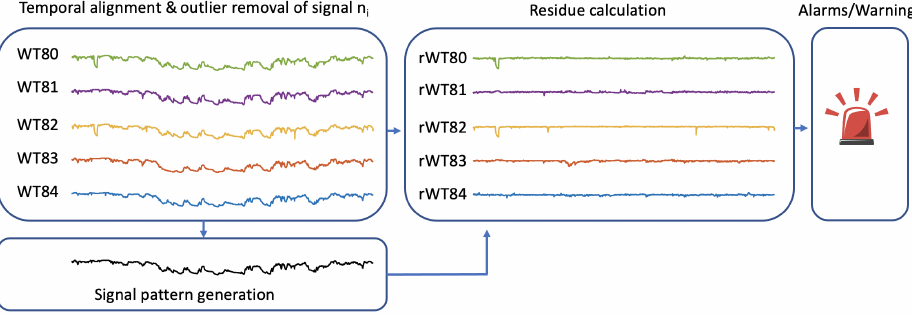
Figure 10. Simplified diagram of the proposed